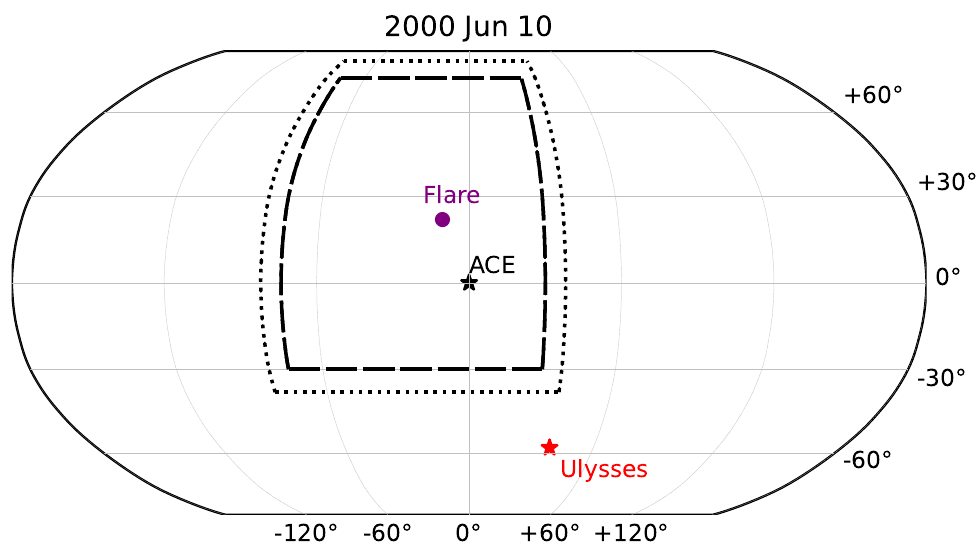
Figure 2. The map shows the footpoints of ACE and Ulysses, as well as the flare, on the solar surface. The black dotted line indicates the particle source boundary in the energy channel of DE2, and the dashed lines indicate the particle source boundaries in the energy channels of both DE3 and DE4, from the best fit parameters.